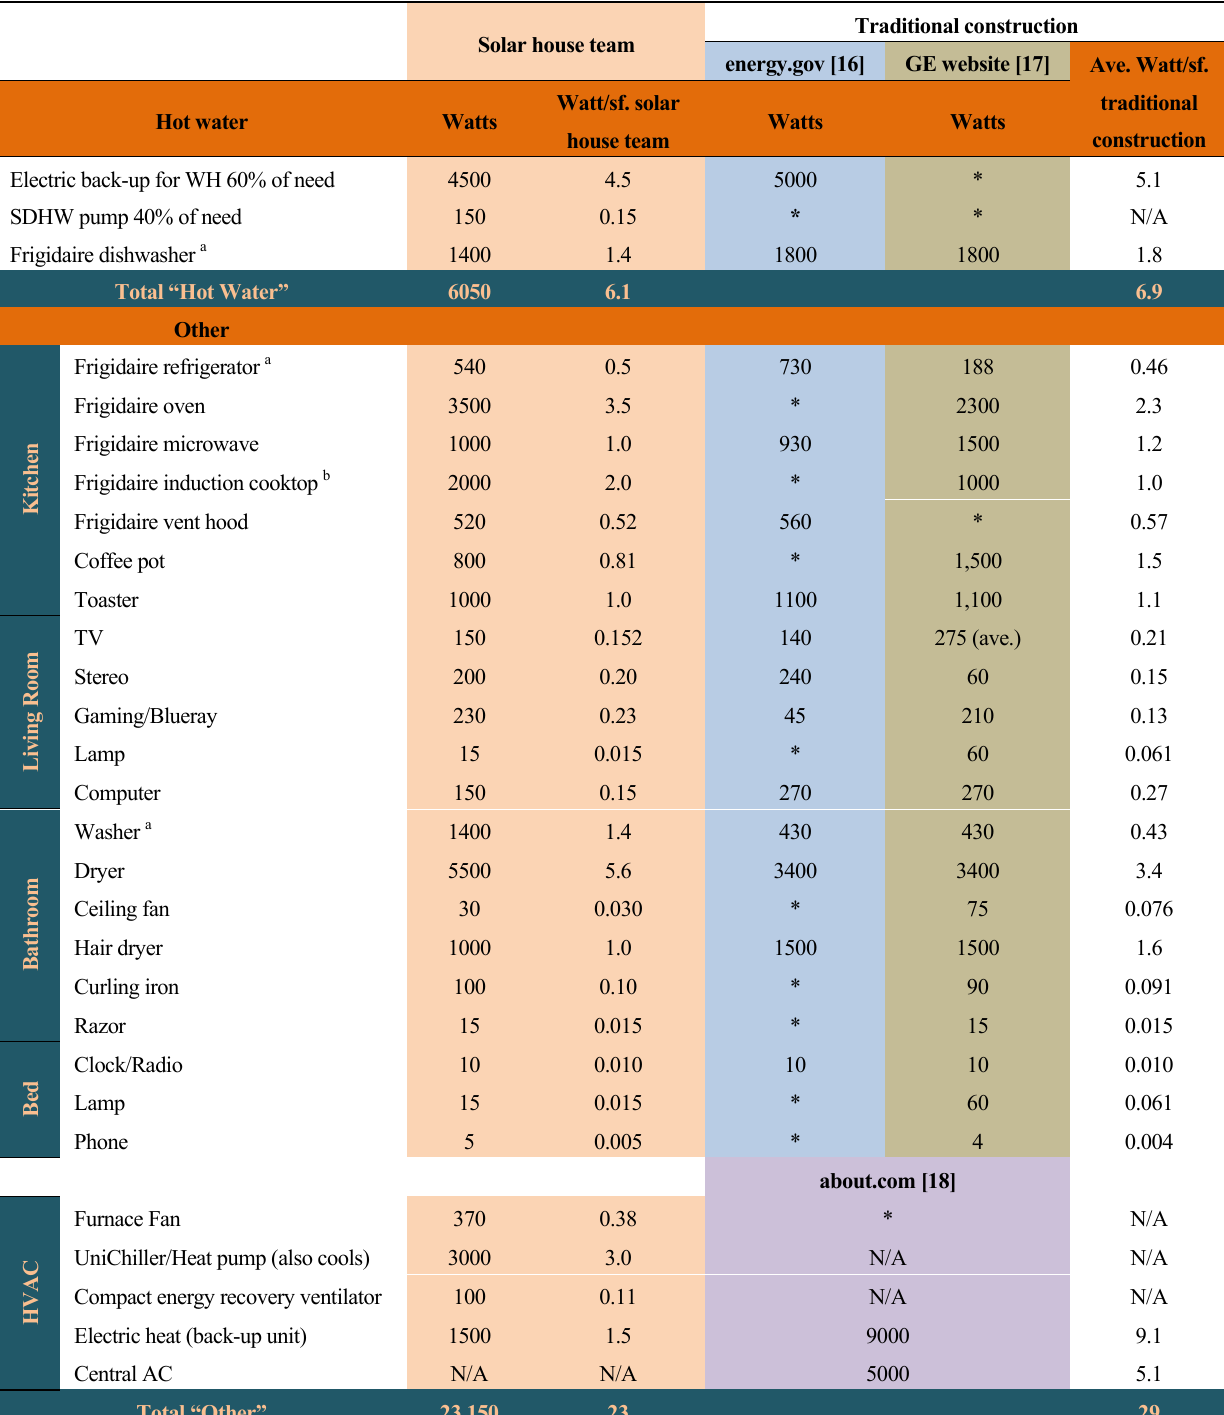
Table 2. Appliance wattages per square feet of